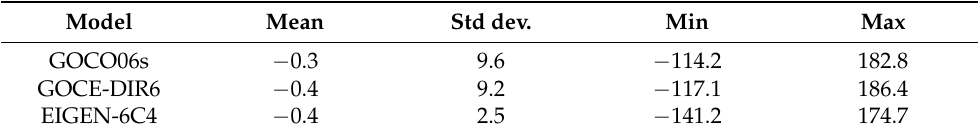
Table 2. Statistics of residual gravimetric anomalies (in mGal) calculated from different geopotential models.